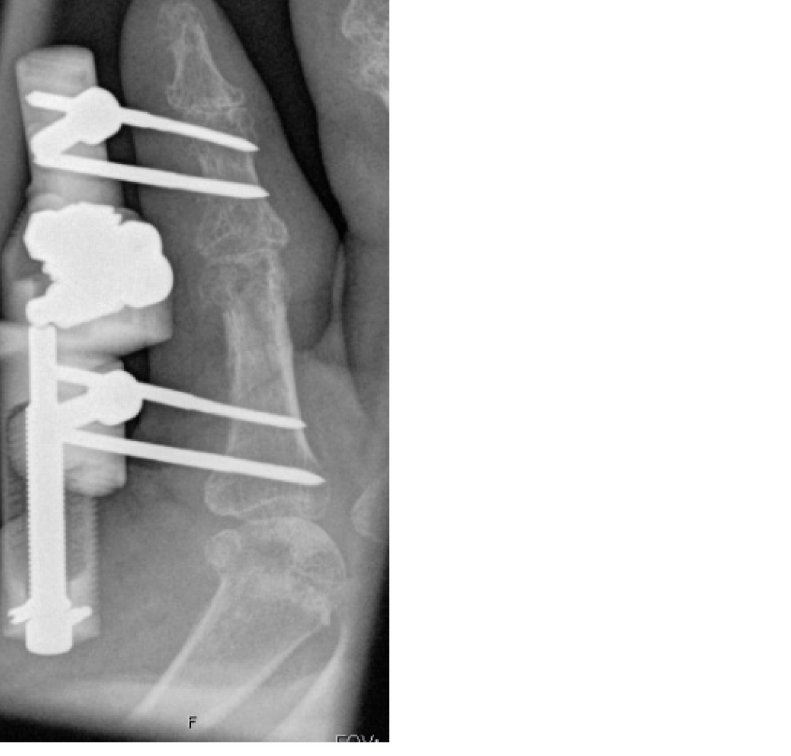
Figure 8. Completely extended PIP joint of the same patient shown in Figures 5–7 at 6 weeks of distraction showing complete release of the PIP joint.